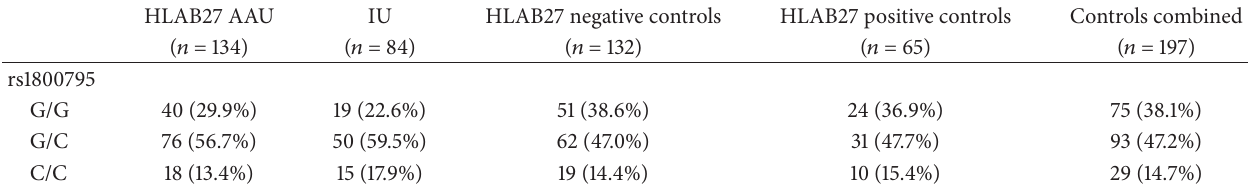
Table 1: Distribution of the investigated gene polymorphisms in patients and controls.